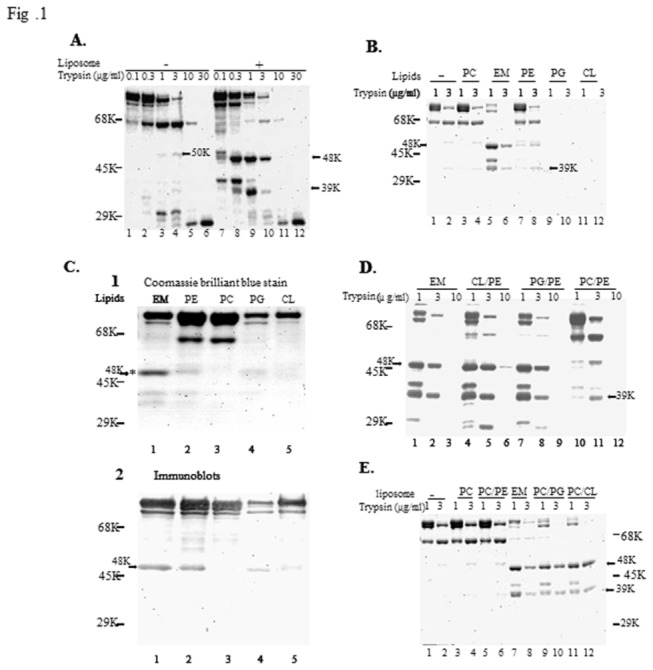
The proteolysis patterns of soluble SecA and various phospholipids-associated SecA.(A) SecA (10 μg) in the absence and presence of liposomes with E. coli lipid mixtures (EM) were treated with trypsin at concentrations indicated, as described in the Materials and Methods. The position of the molecular-markers (protein bovine serum albumin (68-kDa), ovalbumin (45-kDa), and carbonic anhydrase (29-kDa)) is shown by bars in the left hand margin. (B) Proteolysis of SecA was carried out (as defined in panel A) in the absence and presence of variously formed liposomes at concentrations of trypsin indicated. (C) Proteolysis of SecA undertaken (as defined in panel B) using 3 µg/ml; with half of the sample subjected to staining with Coomassie blue and the other transferred to PVDF membrane sheets and developed by immunoblotting with a specific antibody against SecA665-820 -A5. (refs.6,9). (D) and (E) Proteolysis of SecA was carried out according to a similar protocol used in panel A, except that different mixtures of lipids were used (see text).